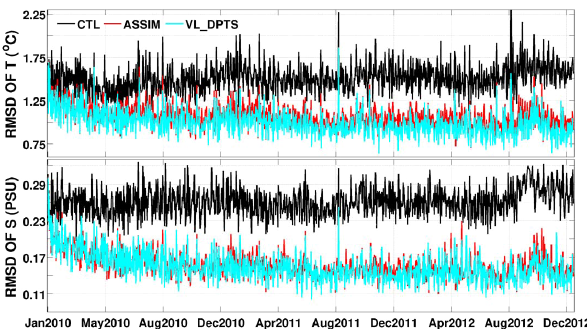
Figure 9. Depth-averaged RMSD of temperature ( ◦ C) and salinity (psu) to 2000m against 47999 Argo profilers in the model domain (100 ◦ W–20 ◦ E, 78 ◦ S–50 ◦ N) from 1 January 2010 to 31 Decem- ber 2012 according to the control run (black) and the prior state of the experiment ASSIM (red) and VL_DPTS (light